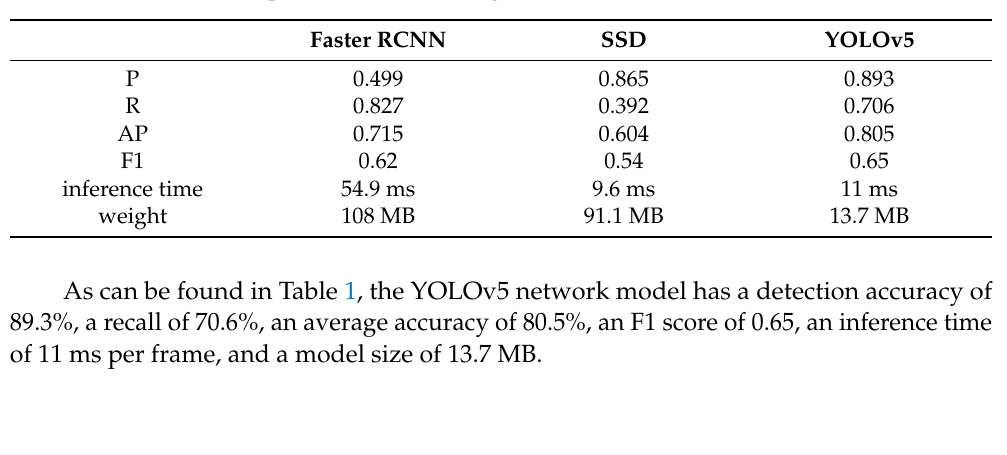
Table 1. Performance comparison of detection